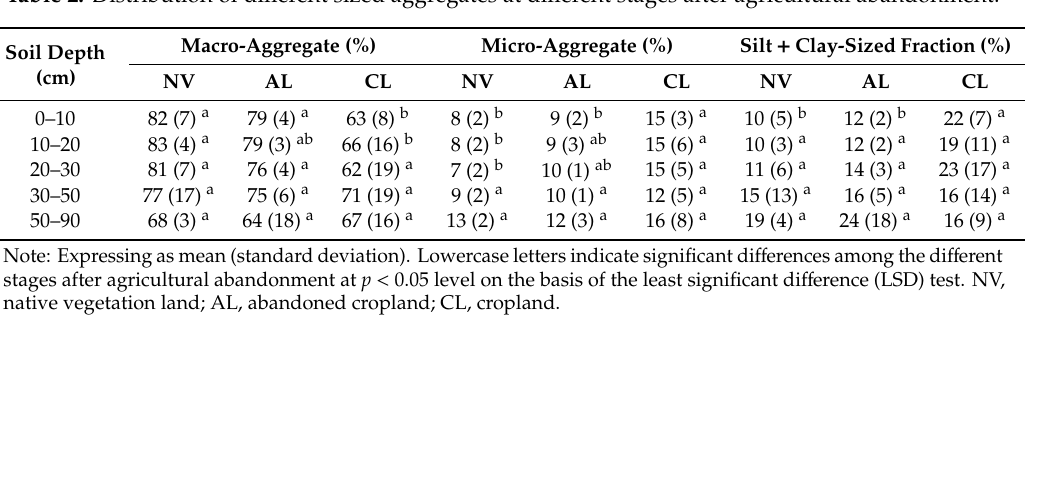
Table 2. Distribution of di ff erent sized aggregates at di ff erent stages after agricultural abandonment. Soil Depth (cm)